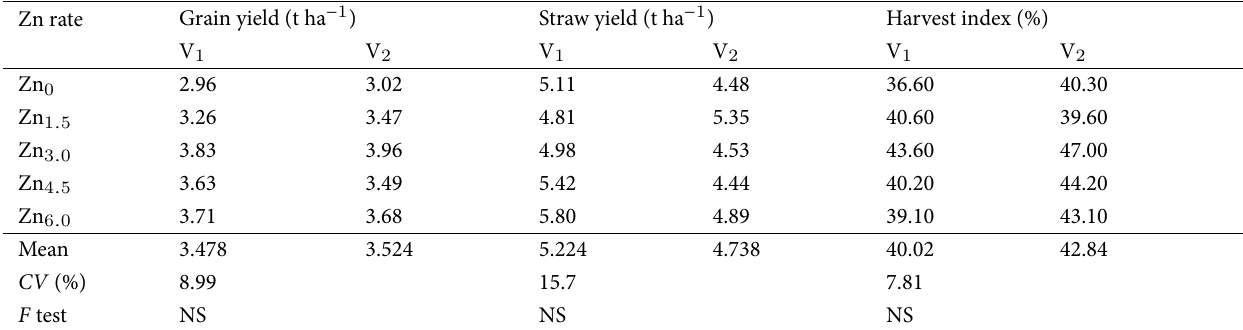
Table 6 Grain and straw yields of wheat influenced by Variety × Zn Rate interaction. − 1 Zn rate Grain yield (t ha